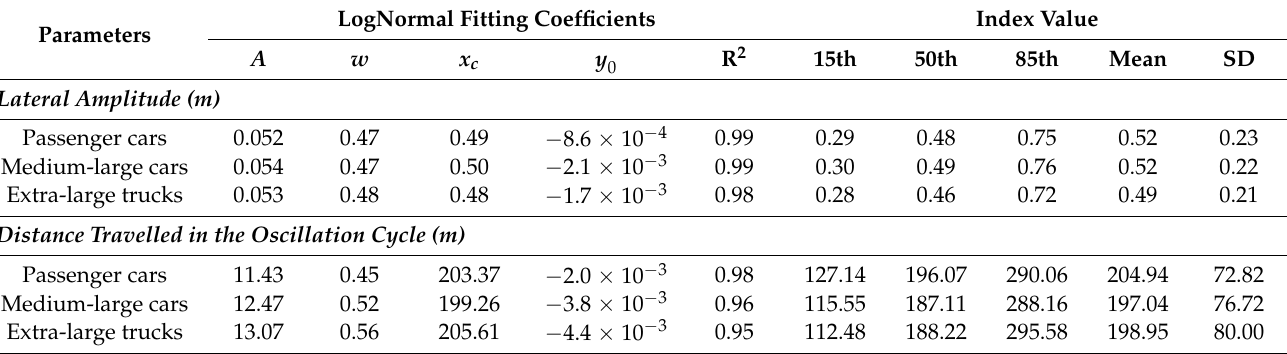
Figure 10. ( a ) Distribution of the LA in different lane positions; ( b ) Distribution of the DTOC in different lane positions.